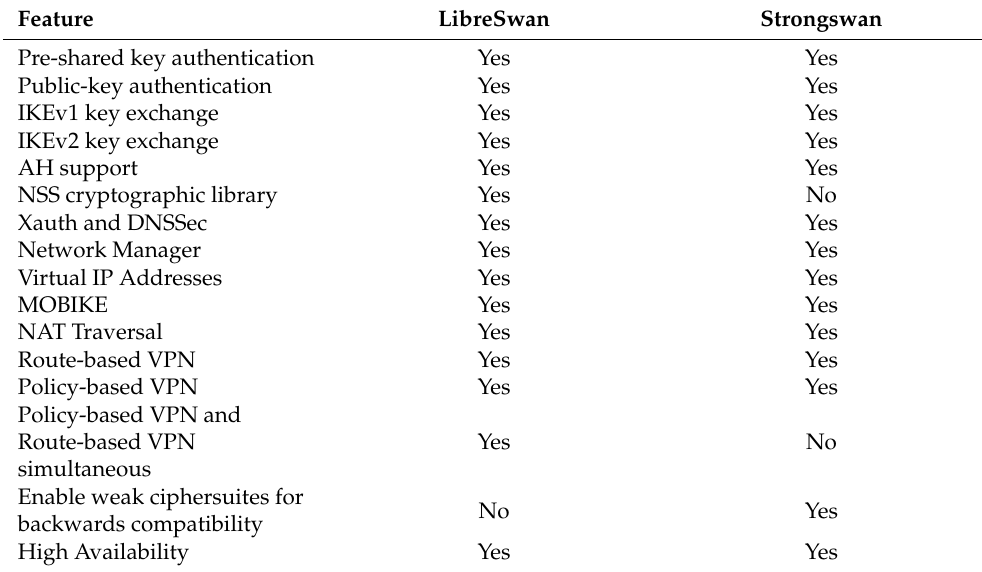
Table 1. Strongswan vs. Libreswan comparison